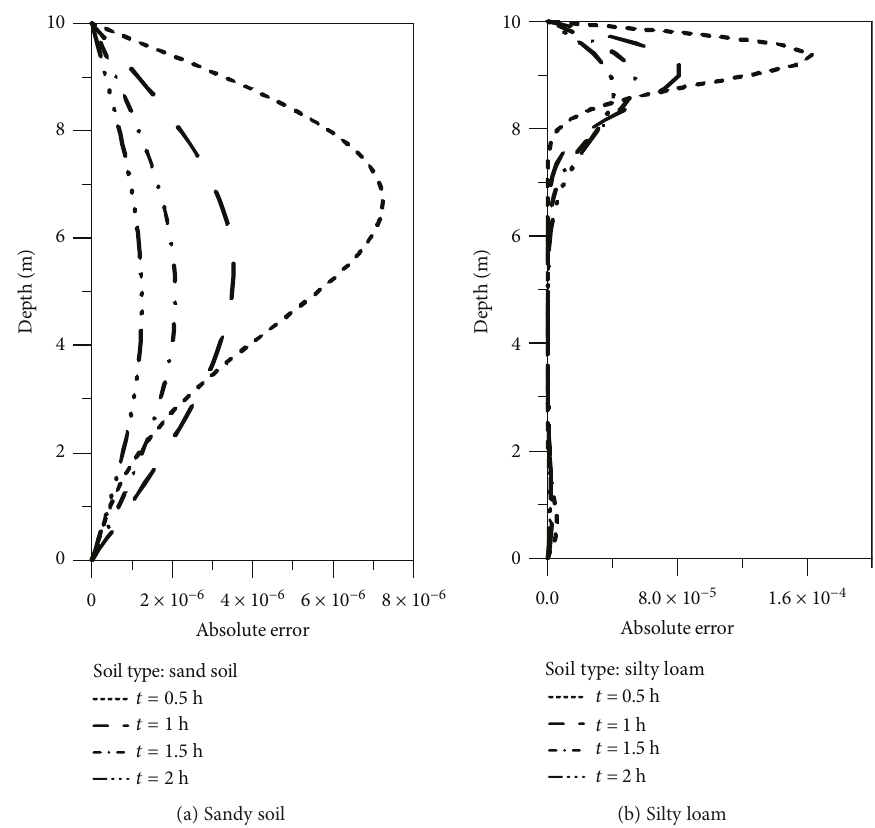
Figure 8: The absolute error of the computed results for sandy soil and silty